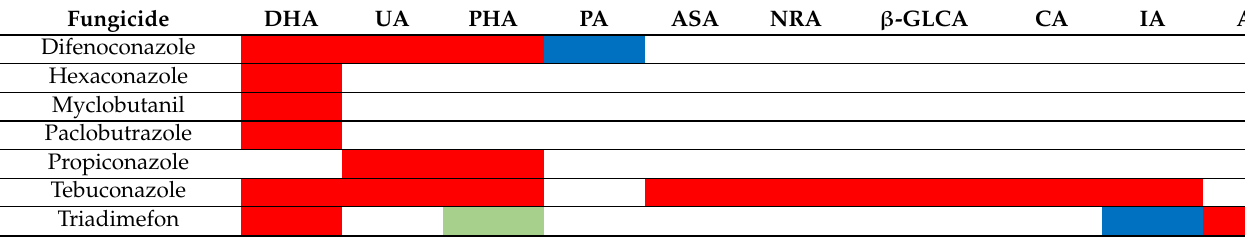
Table 3. Effects of high doses of triazole fungicides on the activities of enzymes found in soil: red cells indicate decreased activities compared to the control, blue cells indicate increased activities compared to the control, green cells indicate no effects of the fungicides on the activity of enzymes, white cells correspond to the lack of available data: